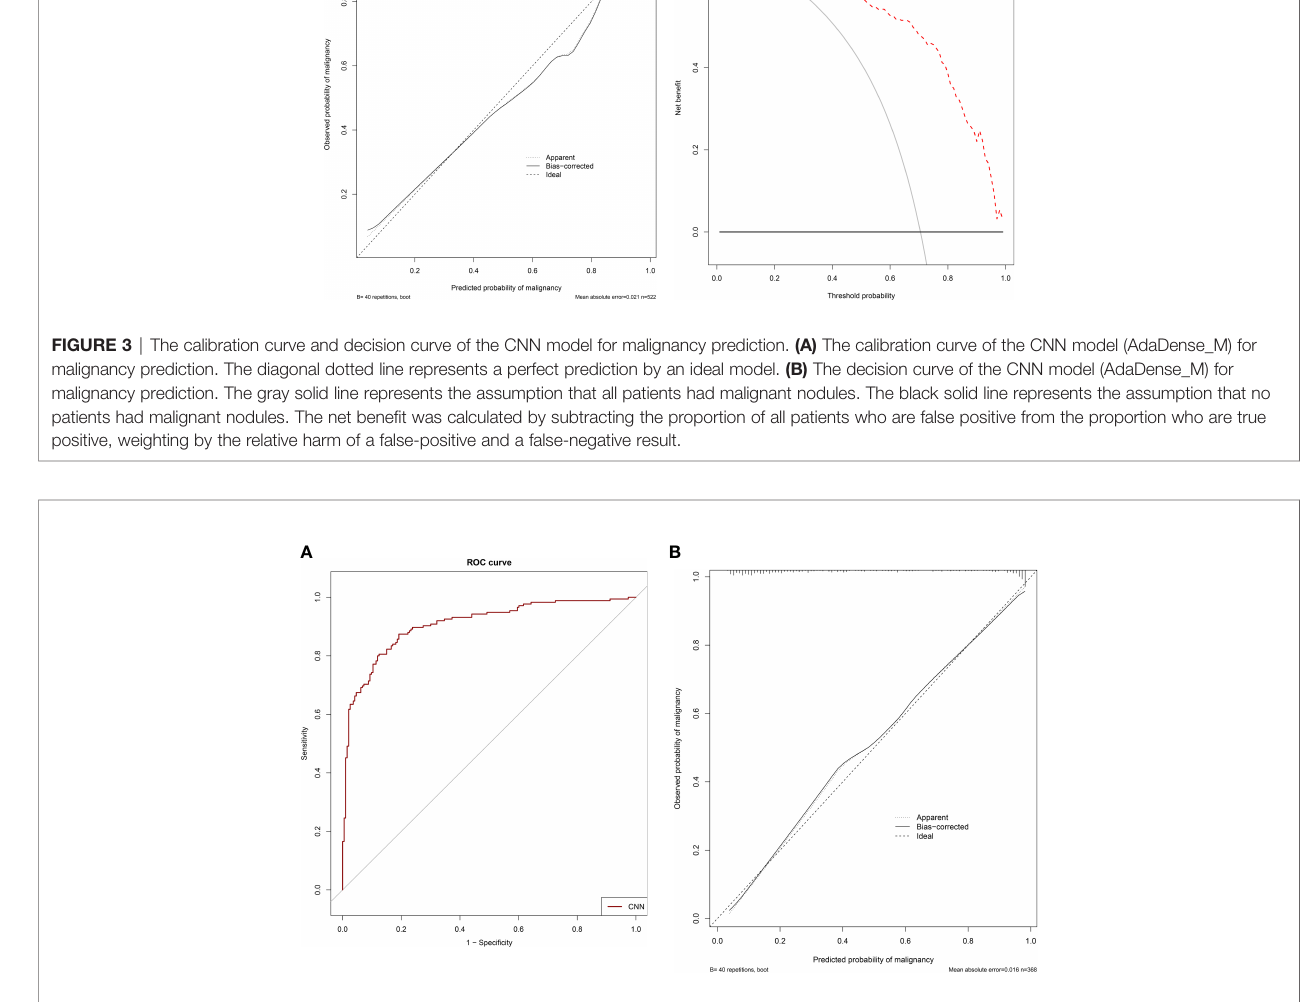
FIGURE 4 | The ROC curve and calibration curve of the CNN model for invasiveness prediction. (A) The ROC curve of the CNN model (AdaDense_M) for invasiveness prediction with an AUC of 0.908 in the testing dataset. (B) The calibration curve of the CNN model (AdaDense_M) for invasiveness prediction in the testing dataset. The diagonal dotted line represents a perfect prediction by an ideal model.